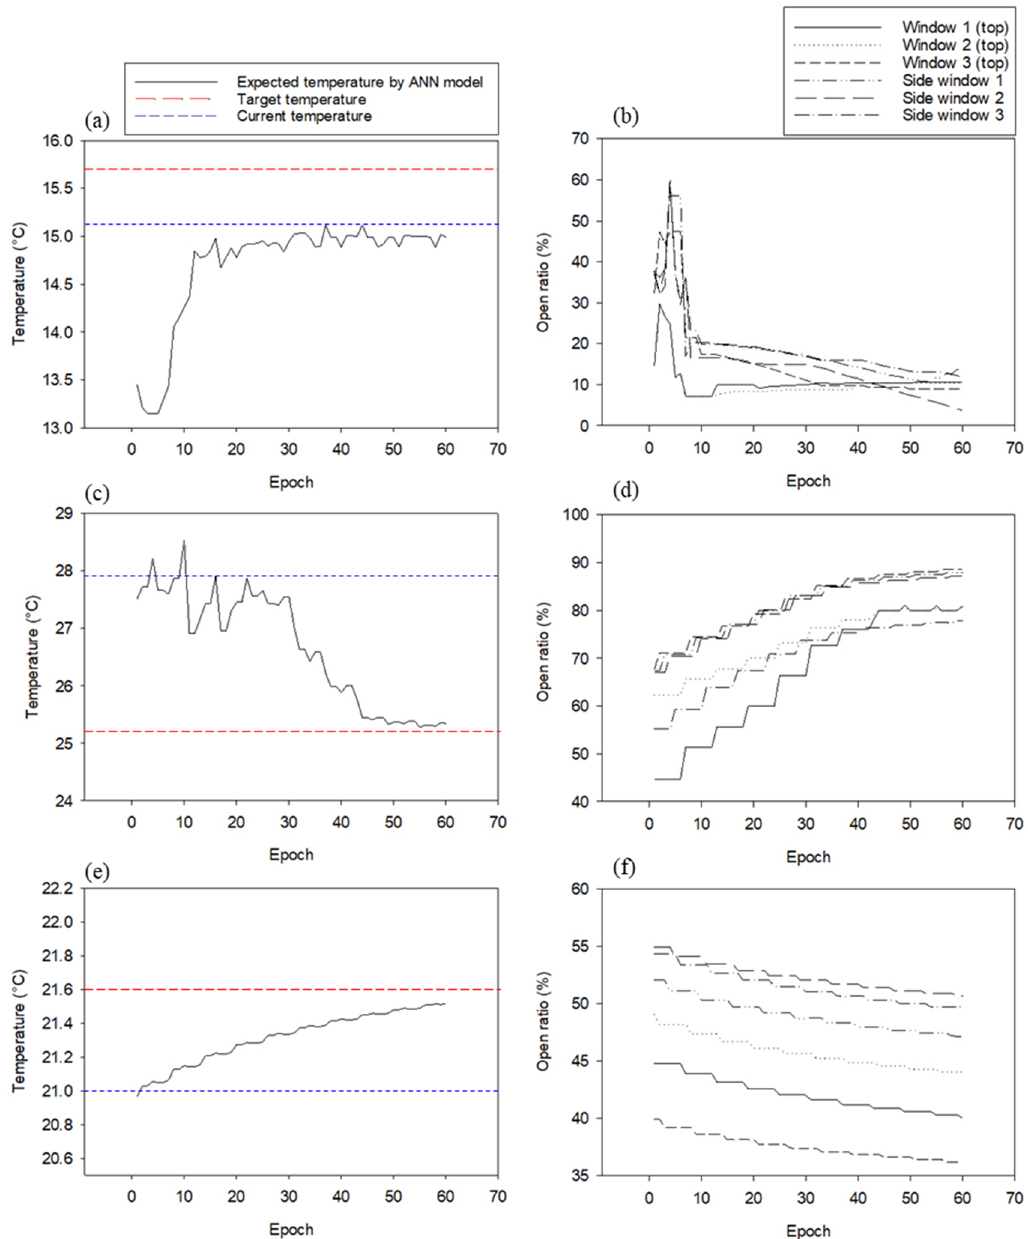
Figure 8. Three cases of predicted temperature change and window open ratio change plot as a result of the operation state of OFNN and ANN during 60 epochs; ( a ) expected temperature changes in case-1; ( b ) changes in window open ratio determined by OFNN in case-1; ( c ) expected temperature changes in case-2; ( d ) changes in window open ratio determined by OFNN in case-2; ( e ) expected temperature changes in case-3; ( f) changes in window open ratio determined by OFNN in case-3.